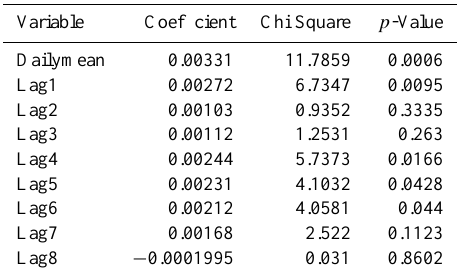
Fig. 8. Asthma incidences by the day of the week within five miles of PM 10 monitoring sites. Table 2. Model statistics for each main effect (preschool age group